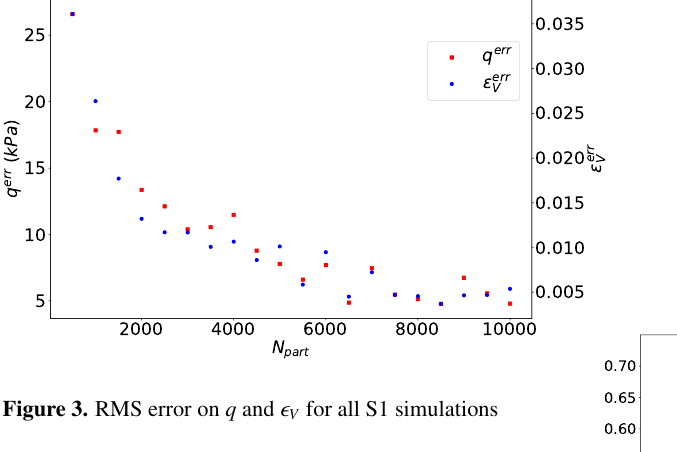
Table 2. Parameters of S2